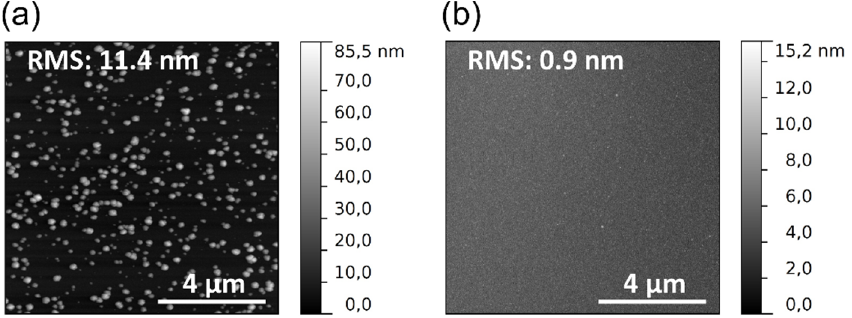
Figure 2. DC BIAS configuration in the reaction chamber. Figure 3 highlights the change in the TiO 2 layer surface morphology deposited in the BIAS configuration at different applied voltage. In both cases 5000 PEALD cycles were performed on Si substrates. The oxygen gas flow amounts 10 sccm while the plasma power was 300 W during the oxygen plasma pulse. All other deposition parameters are identical to the deposition in Figure 1a, which will be labelled as reference in the following. Figure 3. SEM images of TiO 2 layers deposited on Si substrate under the following process conditions: 300 W plasma power; 100 °C substrate temperature; 10 sccm oxygen gas flow corresponding to 5.7 Pa chamber pressure and DC BIAS ( a ) 0 V; and ( b ) +25 V. Compared to the reference surface in Figure 1a, the hillock density is reduced for both depositions within the DC BIAS configuration. As shown in Figure 1a many surface defects in the shape of hillocks have been formed on the reference surface. Their diameter and height is up to 300 nm and 120 nm, respectively. The hillock density and lateral size reduce for the sample shown in Figure 3a, mainly due the shielding and shadowing effect of the metal grid. Only a fraction of electrons, ions and photons reaches the surface, while the substrate is beneath the metal grid. Applying a positive